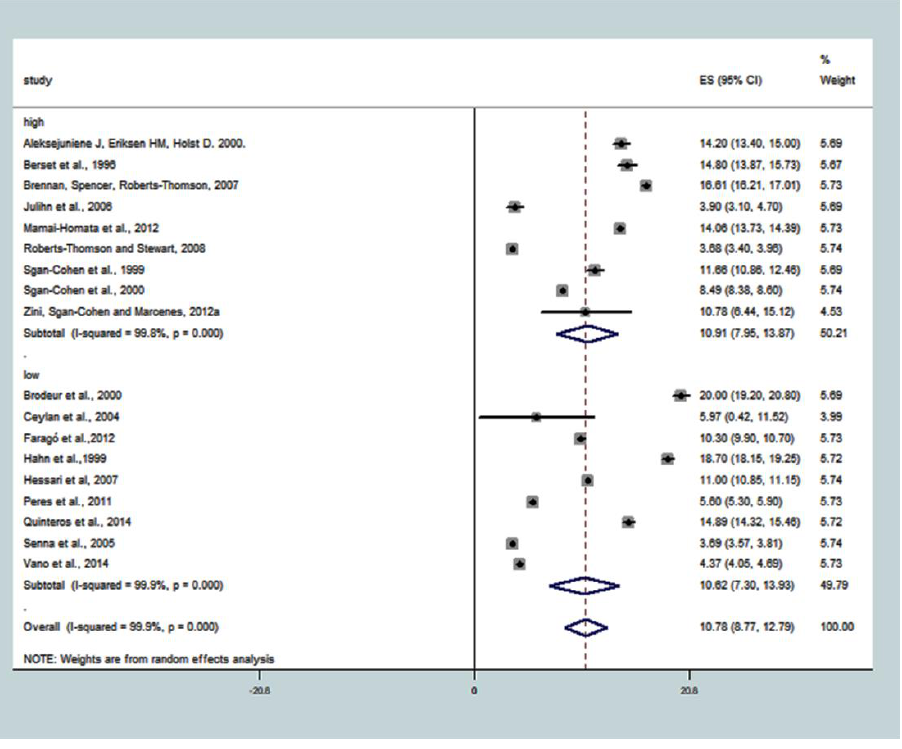
Figure 5. Association between the subgroup ‘university’ and caries experience (DMFT). The pooled effect estimates from the random-effects meta-analysis are shown. Heterogeneity was assessed using the χ 2 test and I 2 statistics. The forest plots are comparing caries in adults with <33.78% of the population with university-low compared with ≥33.78% of the population with a university-higher.